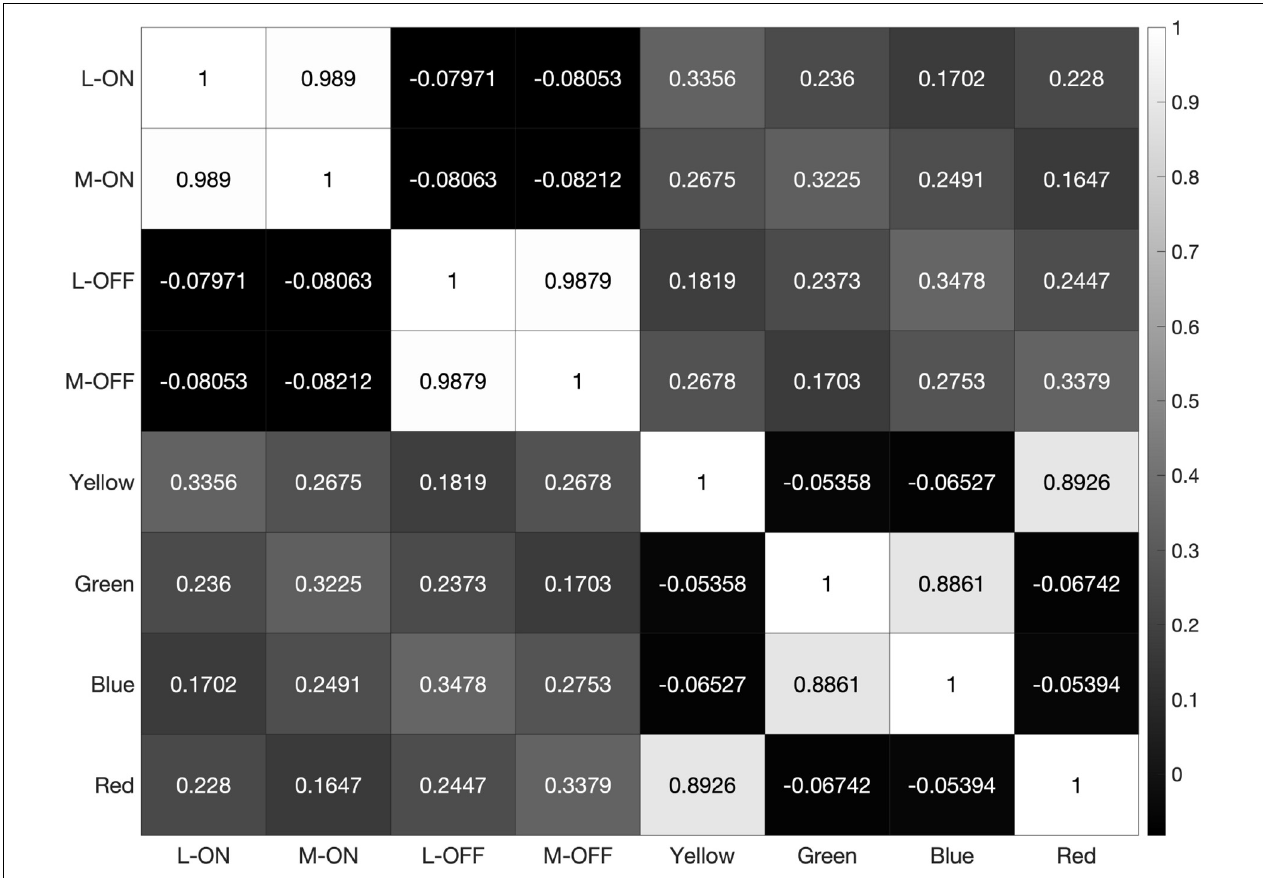
FIGURE 5 | Heatmap of correlations between each of the 8 receptive fields used in our model when exposed to the 2000 × 2000-pixel RGB image shown in Figure 4A . Note the high correlation between the L-ON and M-ON, as well as the L-OFF and M-OFF, receptive fields in rows and columns 1, 2, 3, and 4.